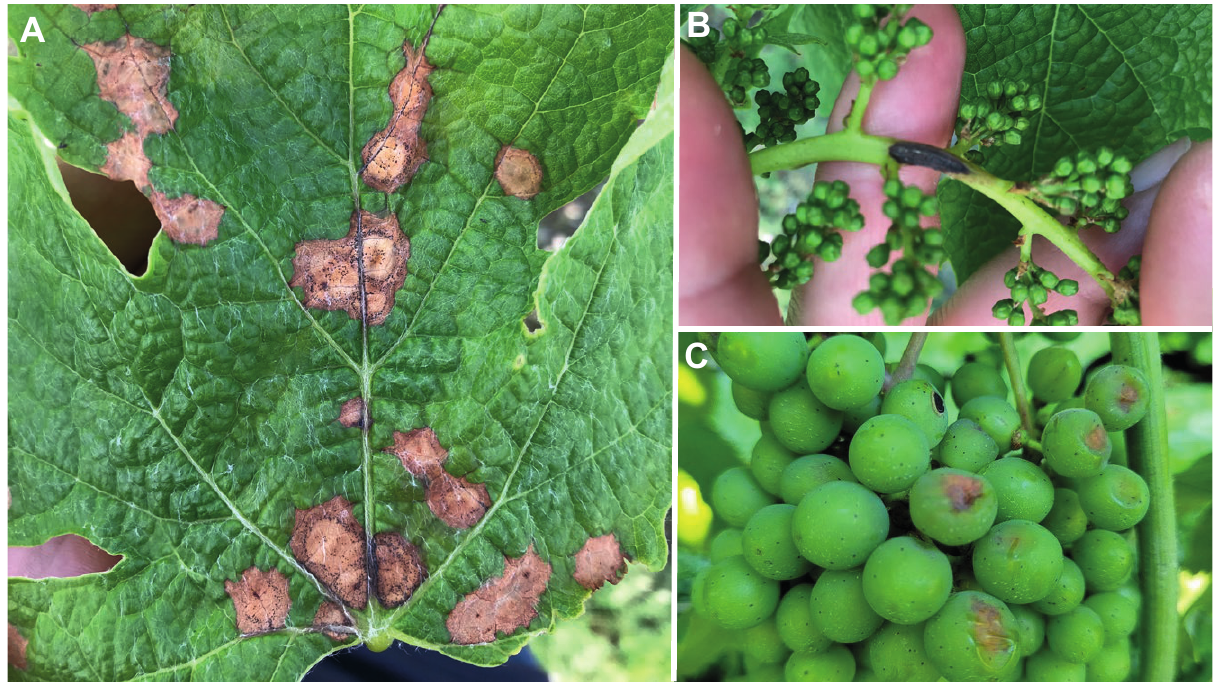
Figure 1. Symptoms on grapevine tissues caused by Phyllosticta ampelicida . Reddish-brown circular lesions on infected leaves, with pycnidia in the lesion centres (A), necrotic spots on the rachis (B), and brown to black spots on berries